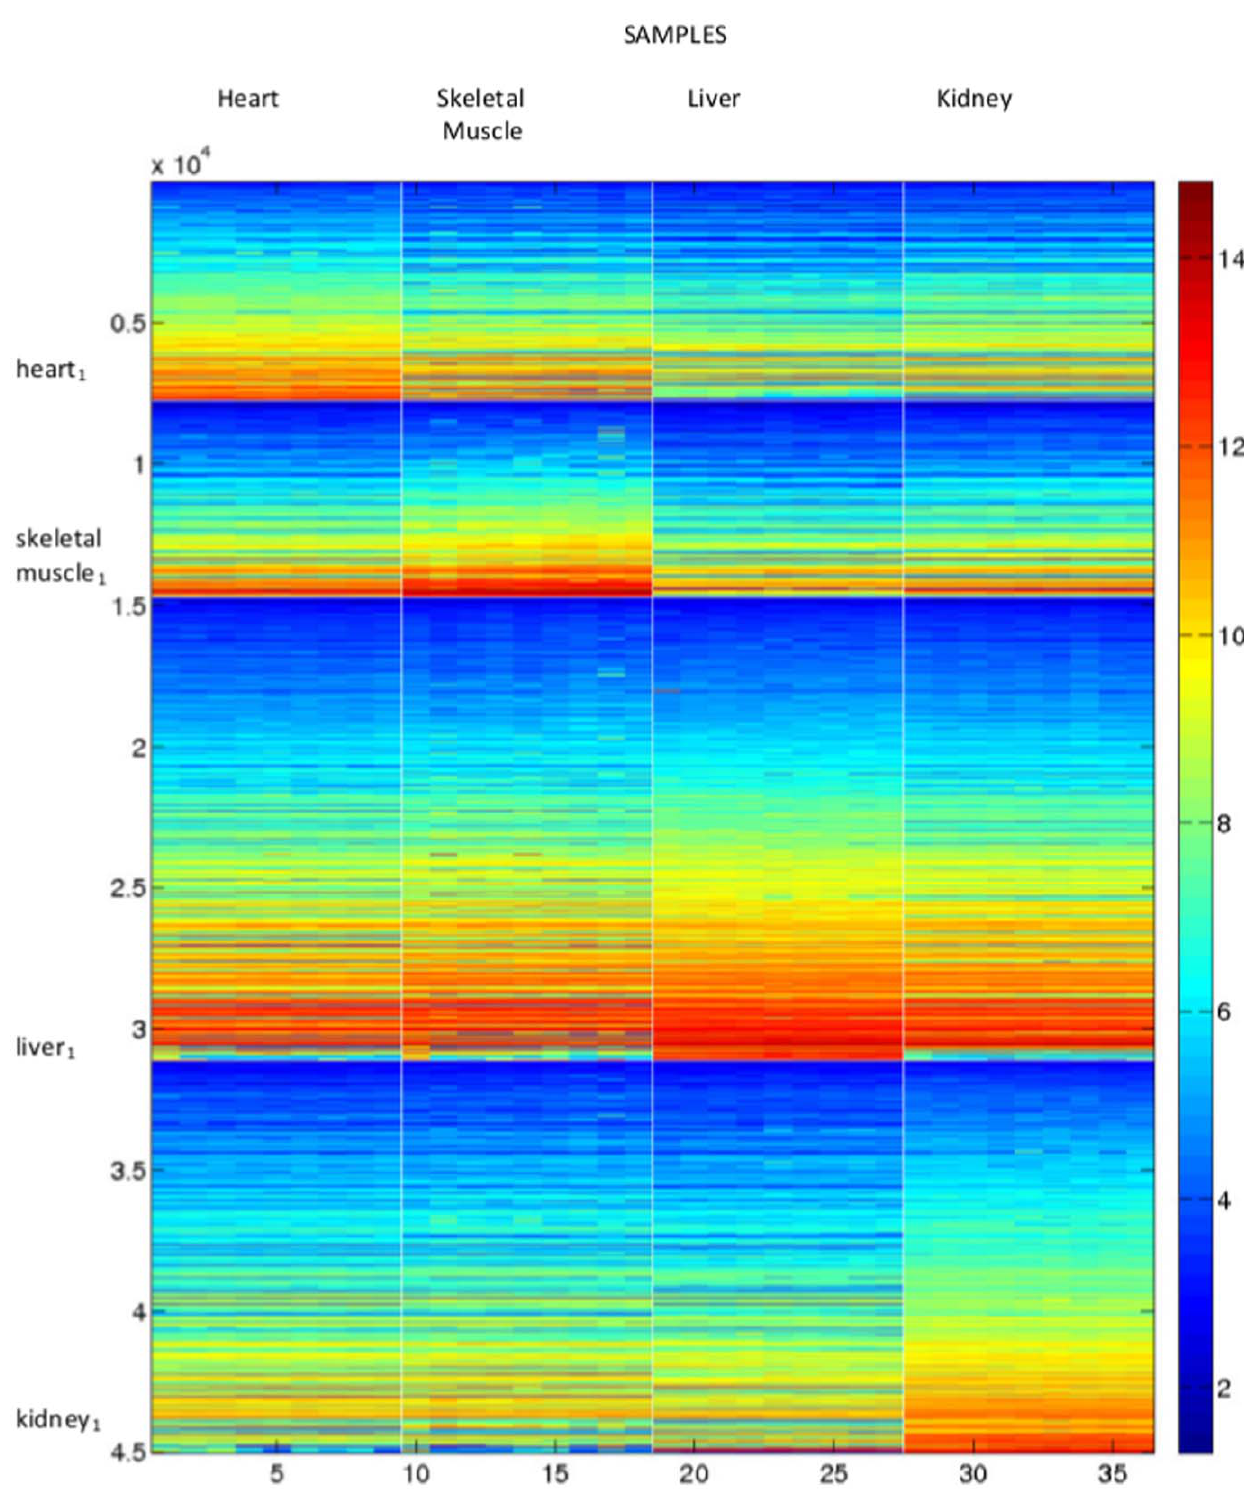
Figure 2. Factorising as a single dataset; reordering using the NMF for k ~ 4 . The columns show the samples and the rows the gene expression for each of the 45037 genes. Genes and samples are organised by cluster number. Elements within each cluster are ordered, with the largest value at the bottom/right. Each tissue is characterised by a group of highly expressed genes; from the top left to bottom right these are heart, skeletal muscle, liver and kidney. For comparison purposes, the characteristic 100 ‘‘best’’ genes in the four columns are names heart 1 , skeletal muscle 1 , liver 1 and kidney 1 .